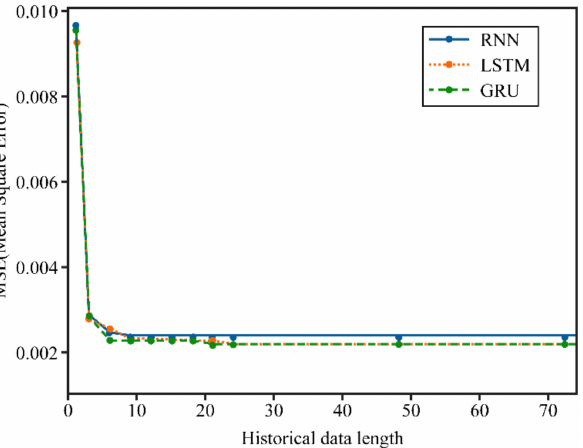
Figure 8. MSE curve according to the past data length of dataset 2. The RNN converges from 9 h, LSTM converges from 24 h, and the GRU converges from 21 h. The error rate at LSTM with 24 h past data and GRU with 21 h past data are the lowest at 0.0022 (Source: [9]).